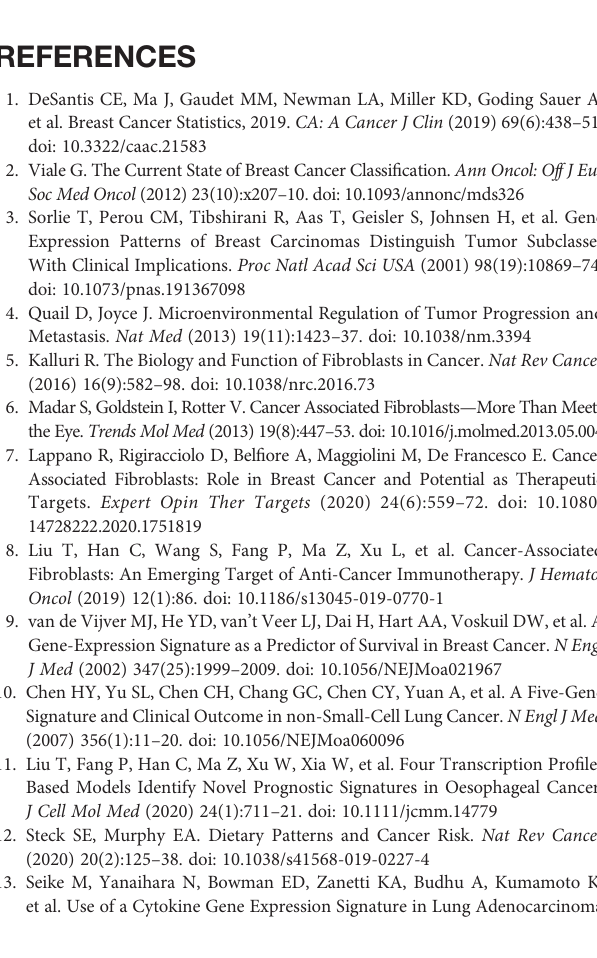
Supplementary Figure 4 | Prognostic relevance of PIK3CA, CDH1, and TP53 mutations in BC. (A, B) Kaplan ‐ Meier survival analyses on PI3KCA and CDH1 mutated patients in TCGA and METABRIC datasets. (C) Survival analyses on BC cases harboring TP53 mutations in three datasets. P value suggested by log-rank test. Supplementary Figure 5 | The relationships between fi ve-cytokine signature status and genomic and epigenomic alterations. (A) The prognostic relevance of WGD events in the TCGA BC dataset. (B) The shorter WGD timing (see Methods ) was revealed among high-RS cases in the TCGA OV dataset. (C) Survival analysis indicated poor clinical outcomes of OV cases with WGD events. (D) The comparison of microsatellite instability (MSI) and microsatellite stable (MSS) based on fi ve-cytokine signature status in TCGA cohort. (E) The comparison of DNA methylation status based on the fi ve-cytokine signature in METABRIC cohort. *** P < 0.001. Supplementary Table 1 | Characteristics and detailed information of included datasets. Supplementary Table 2 | The ligand – receptor pairs of the fi ve cytokines according to the annotation of CellTalker R package. Supplementary Table 3 | The results of correlation analysis between cytokines and inferred CAF proportions among three algorithms (P < 0.05). Supplementary Table 4 | The results of Cox proportional hazards model among 106 candidate